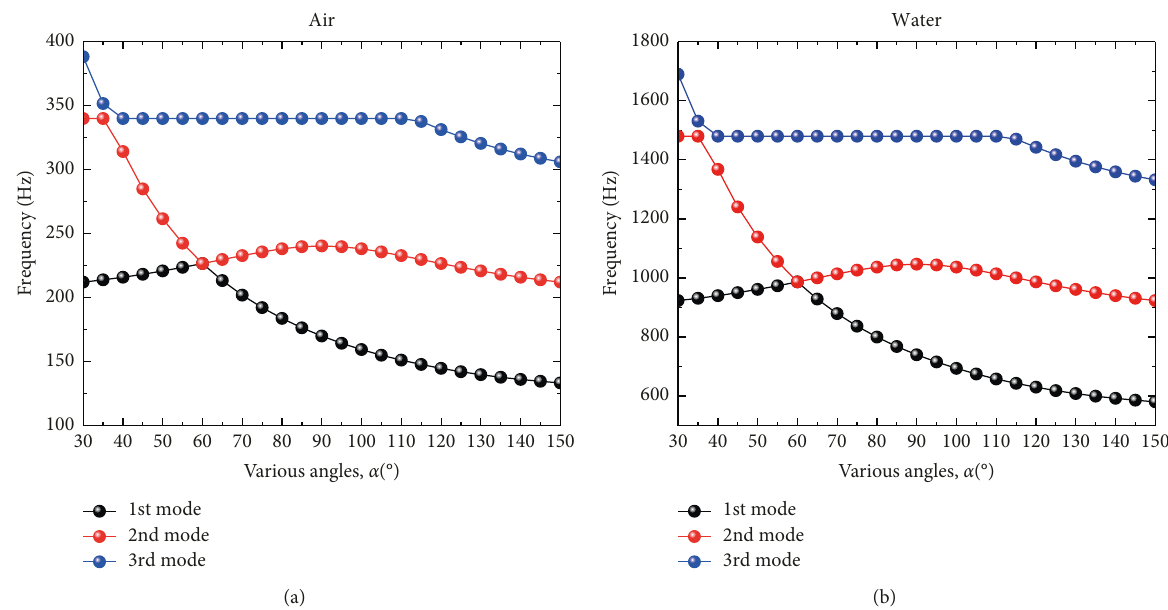
Figure 5: Variation of the frequency of the triangular prism acoustic cavity with various apex angles.